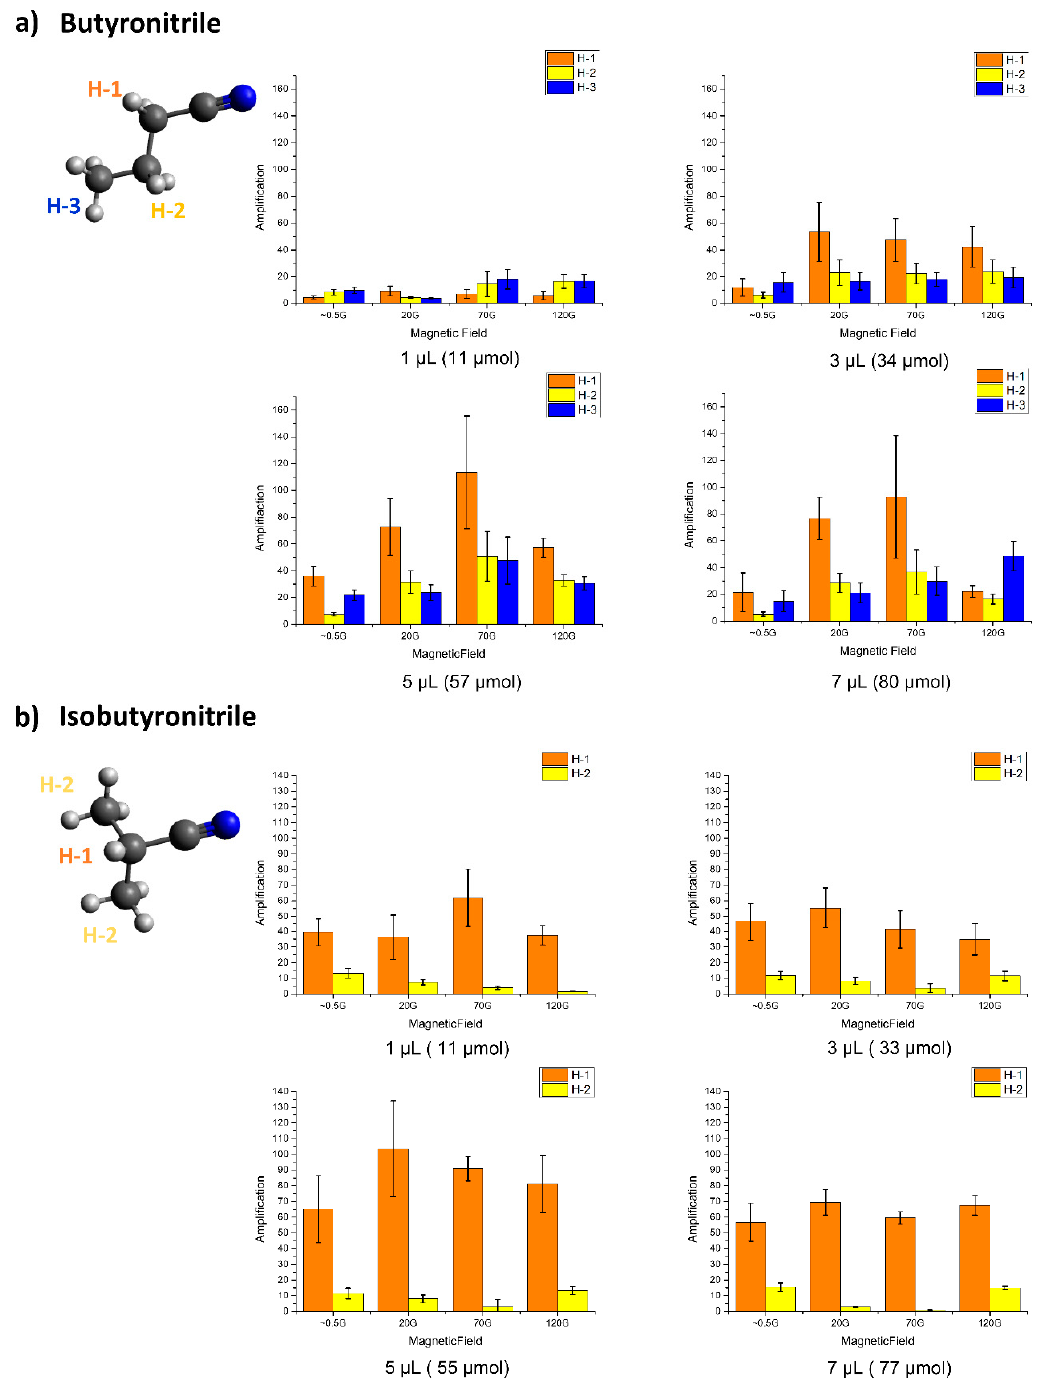
Figure 5. Amplification factors according to the different magnetic fields for different amounts of ( a ) butyronitrile and ( b ) isobutyronitrile in solvent (MeOH- d 4 ). butyronitrile and ( b ) isobutyronitrile in solvent (MeOH- d 4